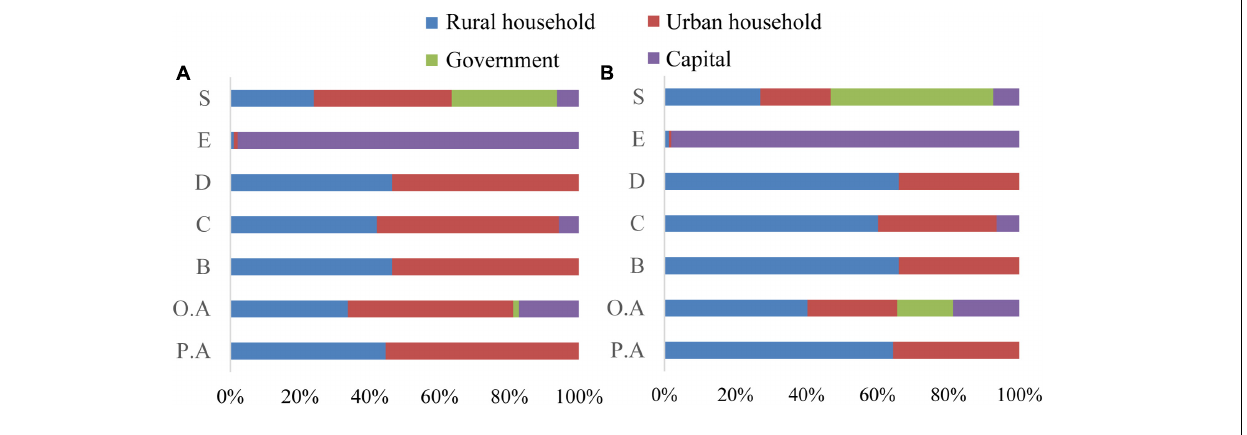
FIGURE 4 | Composition of final water consumption of Zhangye in 2012 (A) and 2017 (B).